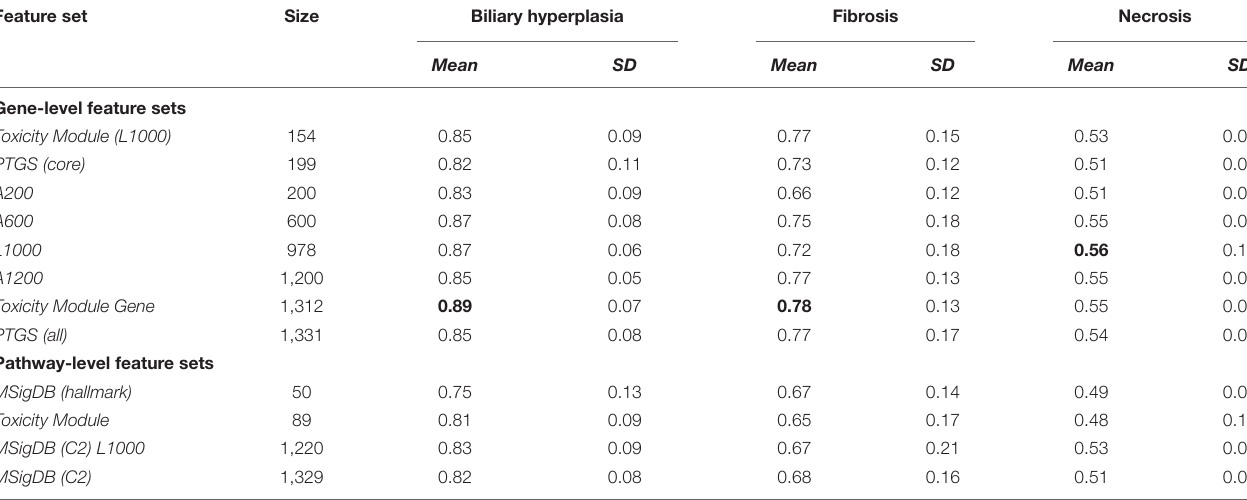
TABLE 3 | Matthews correlation coefficients (MCCs) of single-task DNN models on cross validation data. Feature set